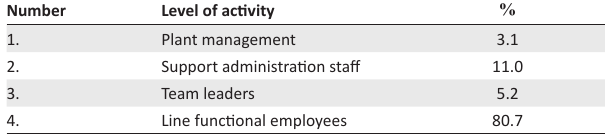
TABLE 1: Percentage breakdown of employees in terms of their level of